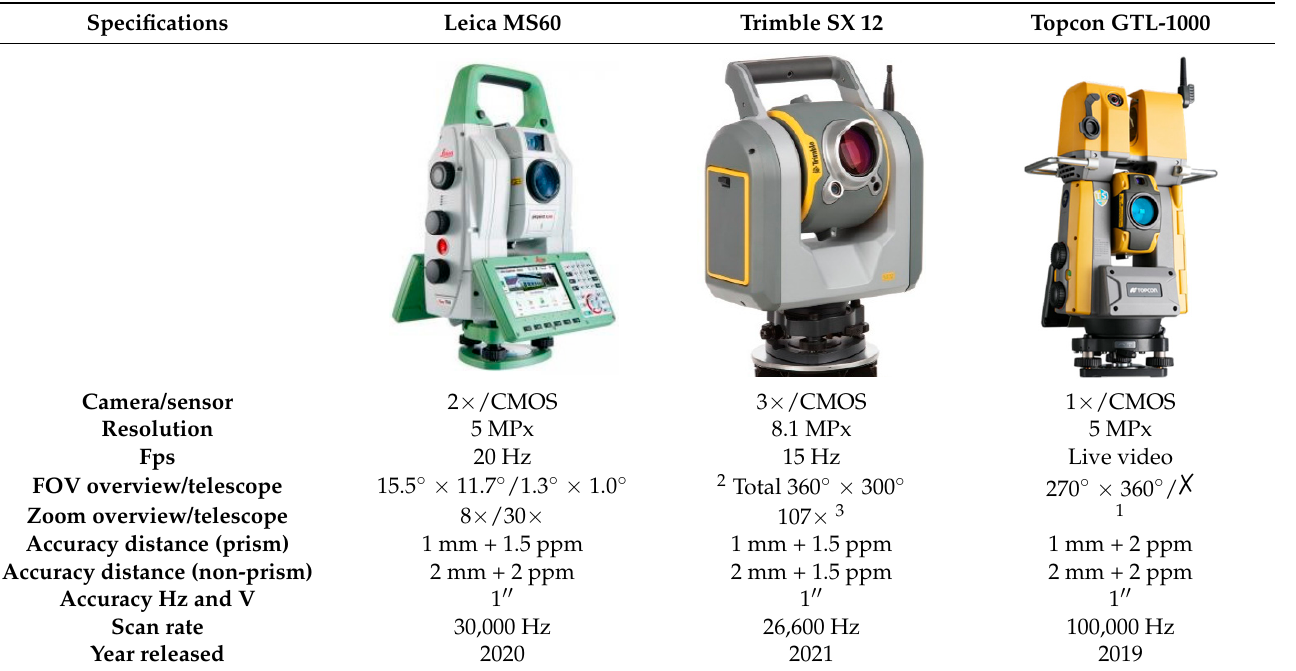
Table 1. Main specifications of currently available IATS